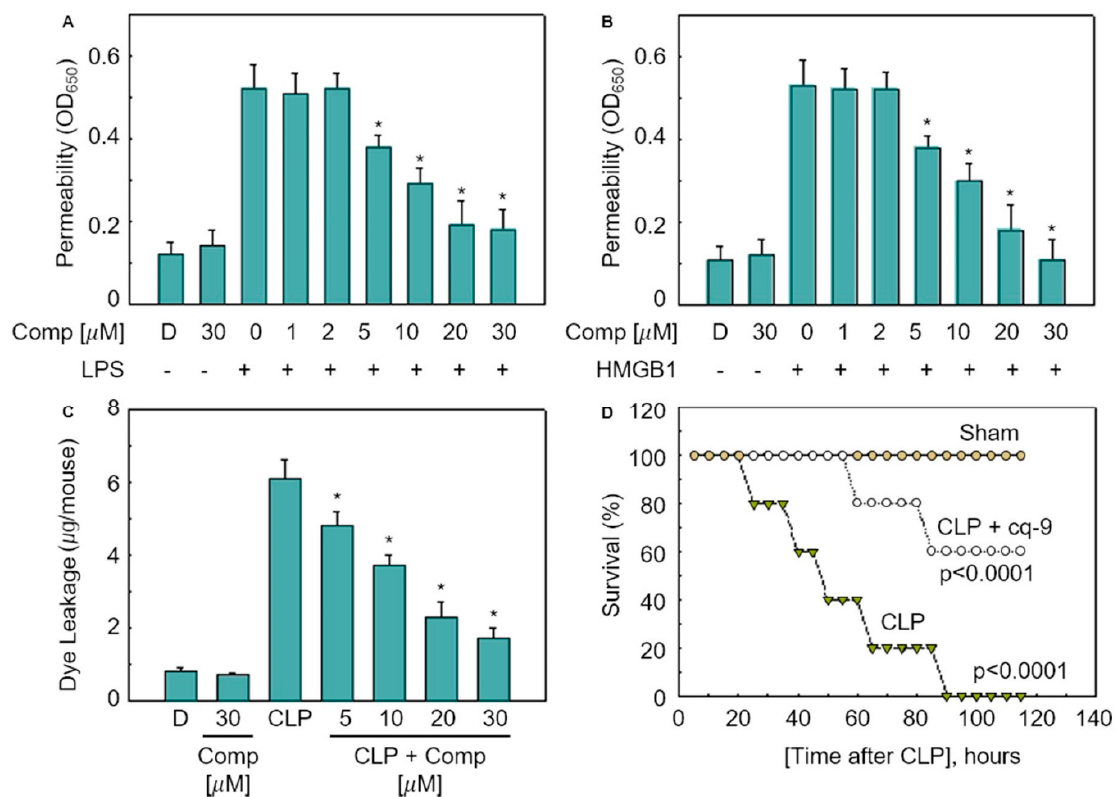
Figure 5. Effects of cq-9 on vascular barrier disruption under septic conditions and septic death model. ( A ) Effects of treatment with different concentrations of cq-9 for 6 h on barrier disruption caused by lipopolysaccharide (LPS), 100 ng/mL, 4 h. ( B ) High mobility group protein 1 (HMBG1), 1 µ g/mL, 16 h were monitored by measuring the flux of Evans blue-bound albumin across human umbilical vein endothelial cells (HUVECs). ( C ) Effects of SFN on caecal ligation puncture (CLP)-induced vascular permeability in mice were examined by measuring the amount of Evans blue in peritoneal washings (expressed ug/mouse, n = 5). ( D ) Male C57BL/6 mice (n = 20) were administered compounds cq-9 at 12 and 50 h after CLP. Animal survival was monitored every 12 h after CLP for 132 h. Control CLP mice and sham-operated mice were administered sterile saline (n = 20). Kaplan–Meier survival analysis was used to determine the overall survival rates vs. CLP-treated mice. However, our human pathogenicity experiments did not show any effect. * Significantly different at the 0.05 level.